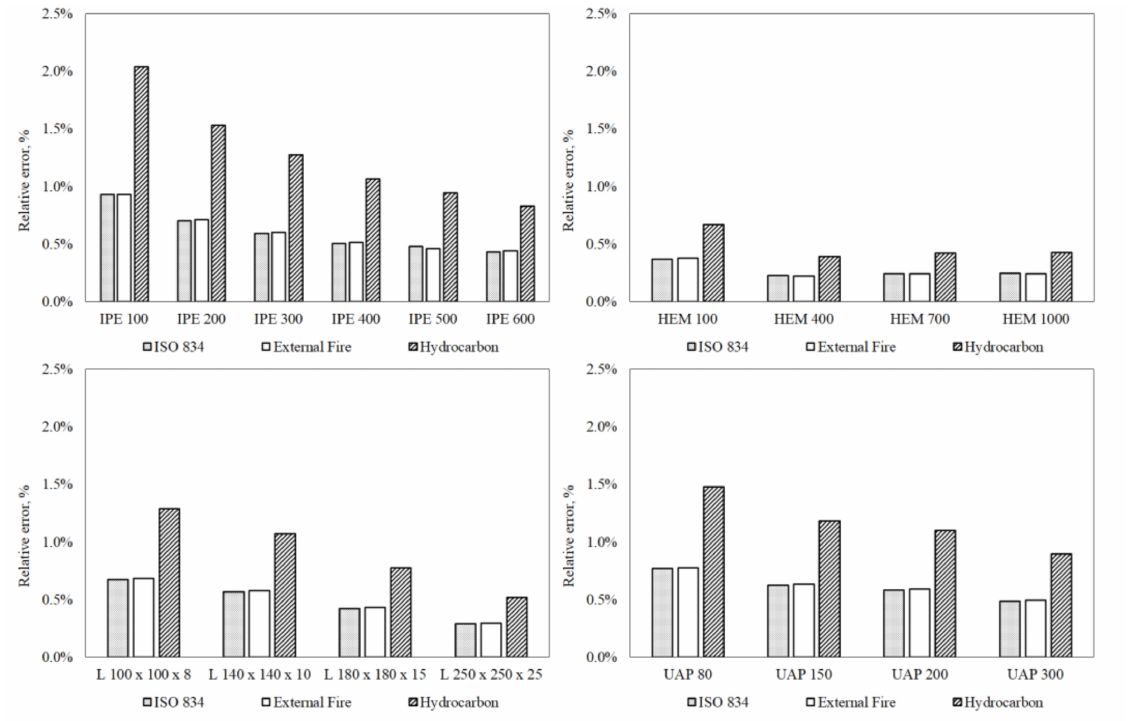
Figure 10. Relative error of the obtained results in relation to the EC3